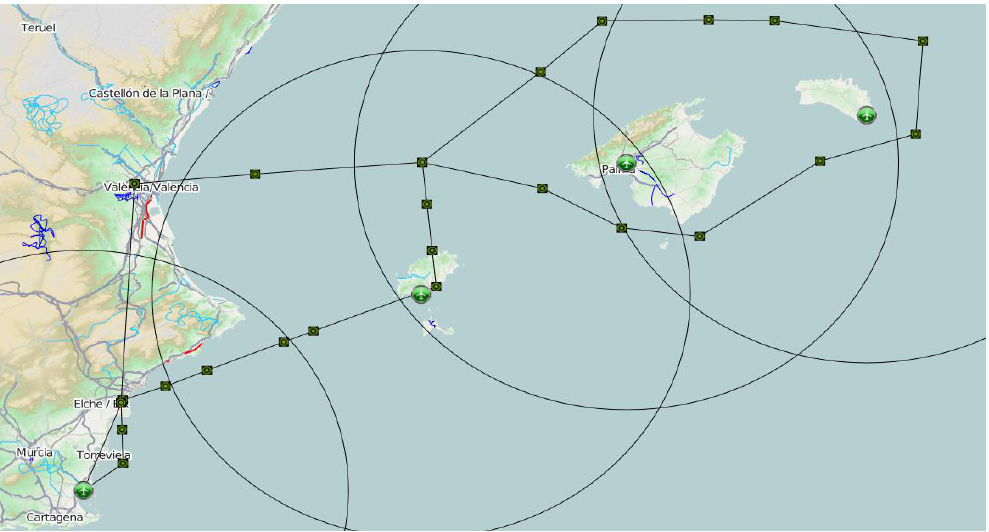
Figure 2. Emergency airfield selected for an MQ-9 RPAS engine failure contingency. Circles indicate maximum MQ-9 gliding distance (estimated around 90 NM) from mission cruise altitude.